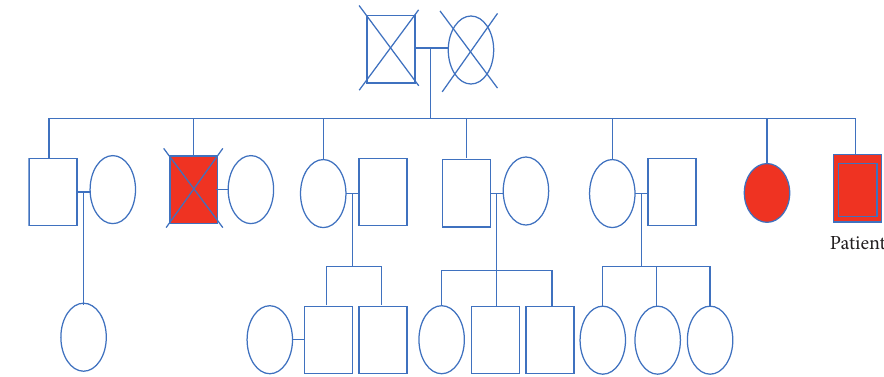
Figure 2: Family pedigree of the patient showing affected individuals. Table 1: Laboratory values over the